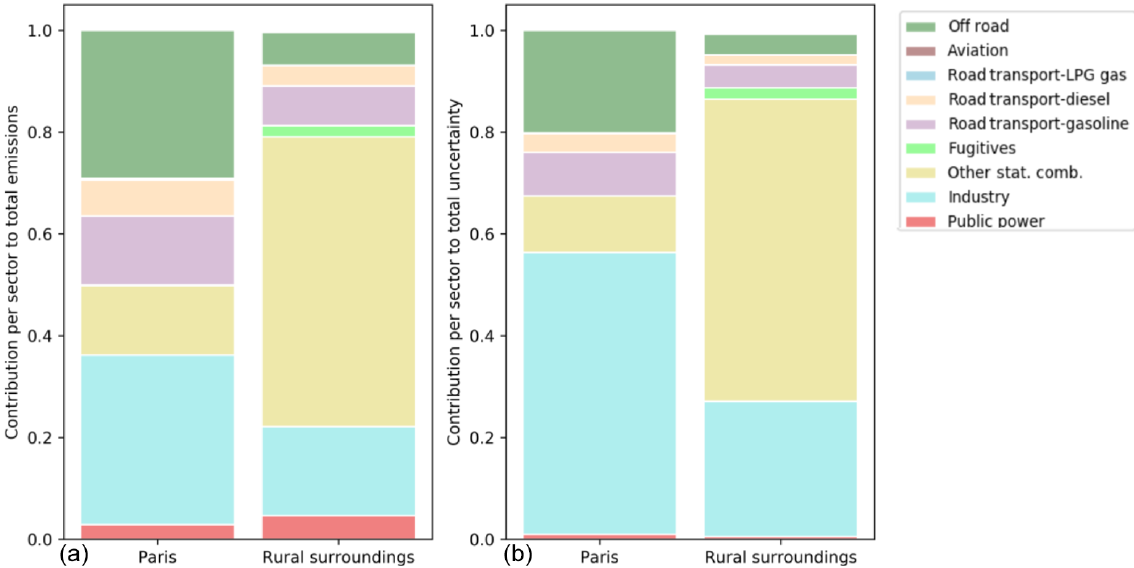
Figure 17. Contribution of source sectors to the total emissions (a) and the total uncertainty (b) in CO for Paris and its surroundings, summing to 100%. See Fig. 15 for the exact locations of these